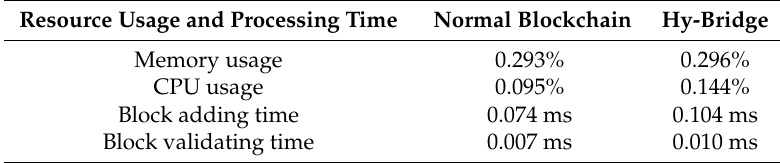
Table 3. Average resource usage and processing time to handle the transactions in Hy-Bridge and the normal